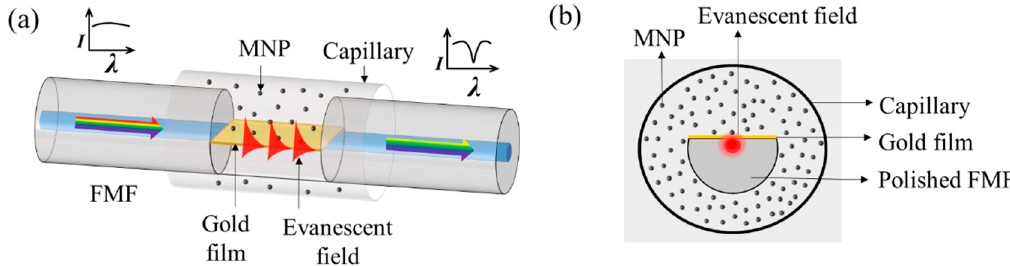
Figure 1. Schematic diagrams of ( a ) the proposed sensor and ( b ) a cross section of the sensor. A broadband incoming light from the left is partially absorbed due to the SPR, producing the notched spectrum of the outgoing spectrum on the right end.